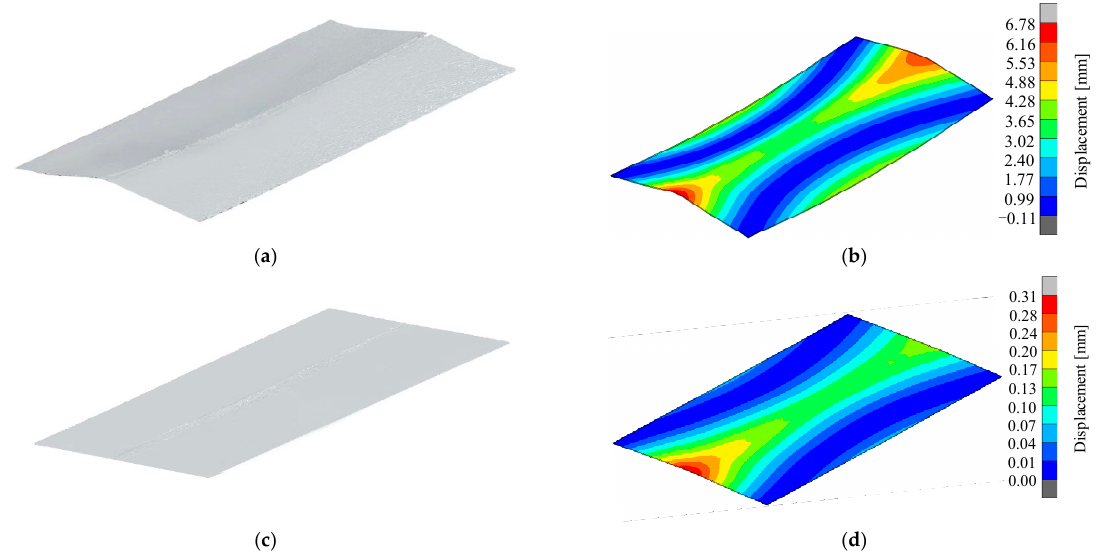
Figure 16. Comparison between the scanned form of the diagram of the sheet distortion and the numerical simulation results: ( a ) scanning diagram of conventional welding; ( b ) diagram of the simulation results of conventional welding; ( c ) scanning diagram of welding with a trailing hybrid high-speed gas fluid field; ( d ) diagram of the simulation results of welding with a trailing hybrid high-speed gas fluid field.